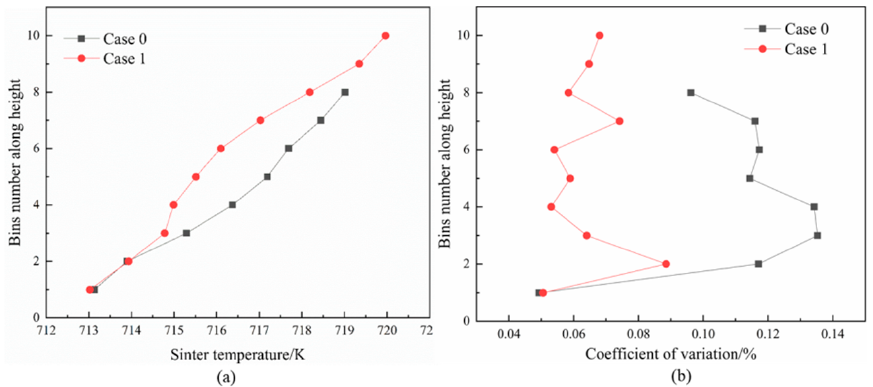
Figure 4. Sinter temperature and its standard deviation distribution in bins 1~10. ( a ) Sinter temperature distribution; ( b ) coefficient of variation distribution.